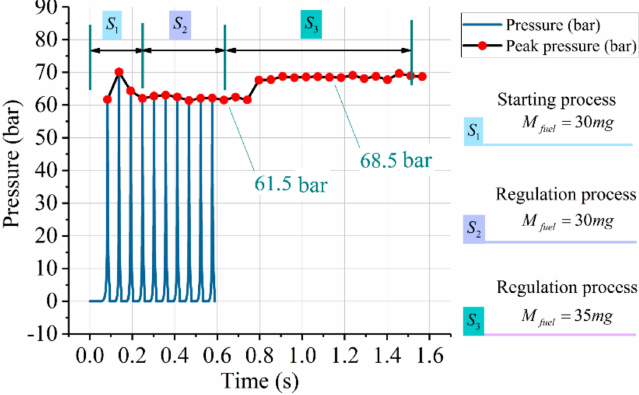
Figure 14. In-cylinder pressure of combustion chamber.